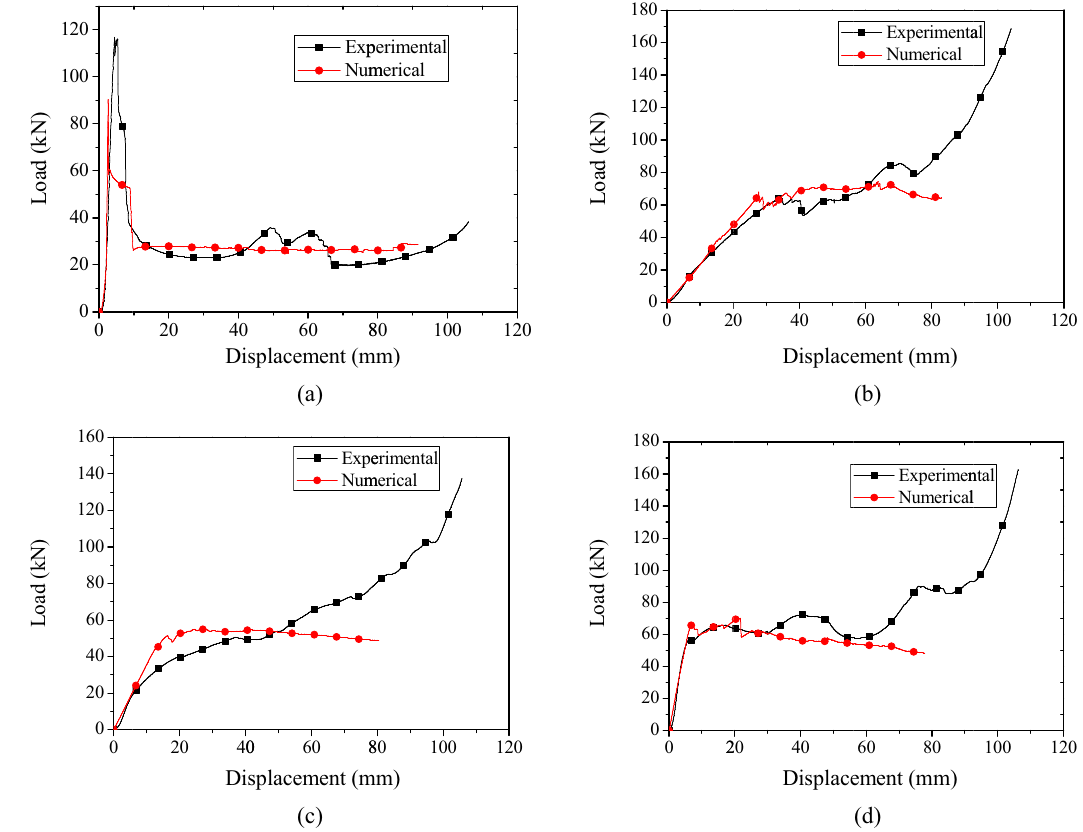
Figure 16: Comparison of load – displacement curves between the numerical simulations and results: ( a ) vertical lattice webs, ( b ) 45 trapezoid space lattice webs, ( c ) 60 trapezoid space lattice webs, ( d ) 75 trapezoid space lattice webs.